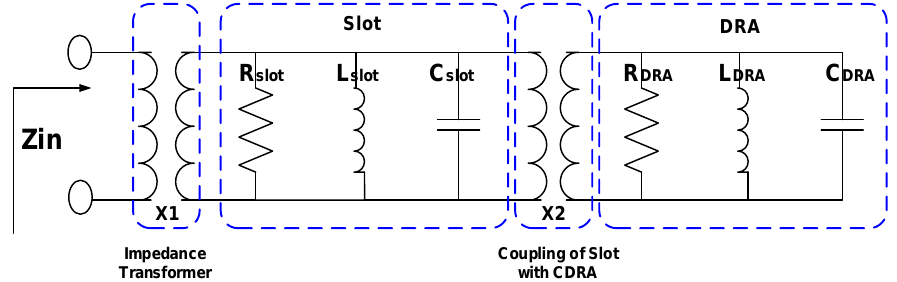
Figure 2. Equivalent circuit model of the complete antenna system.